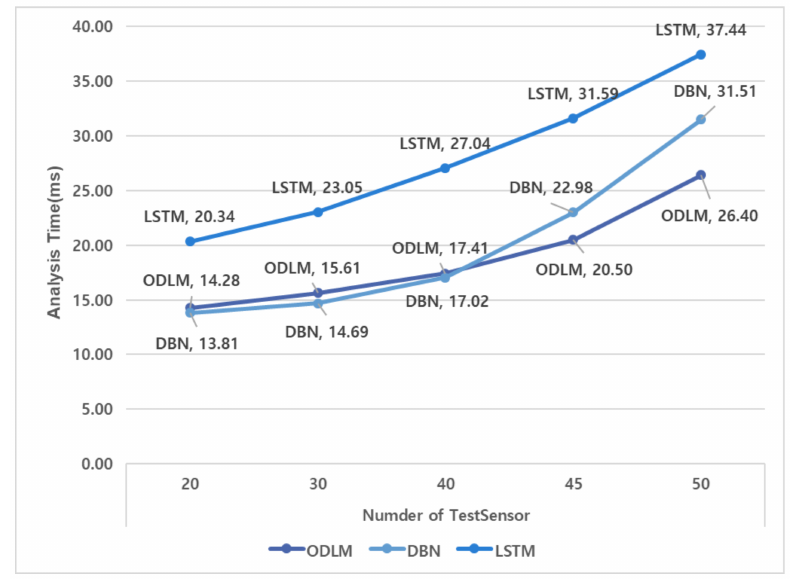
Figure 13. The comparison of the average response time according to the kinds of sensors.